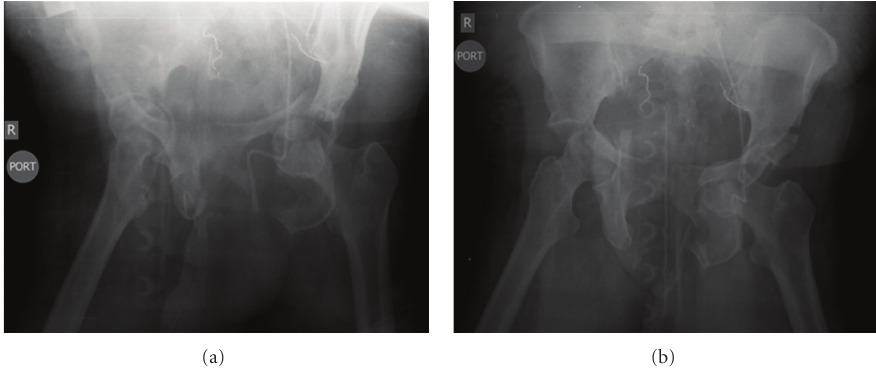
Figure 1: (a) Anterior-posterior radiographic image of pelvis—courtesy of the Botsford General Hospital Radiology Department. (b) Ante- rior-posterior radiographic image of pelvis—courtesy of the Botsford General Hospital Radiology